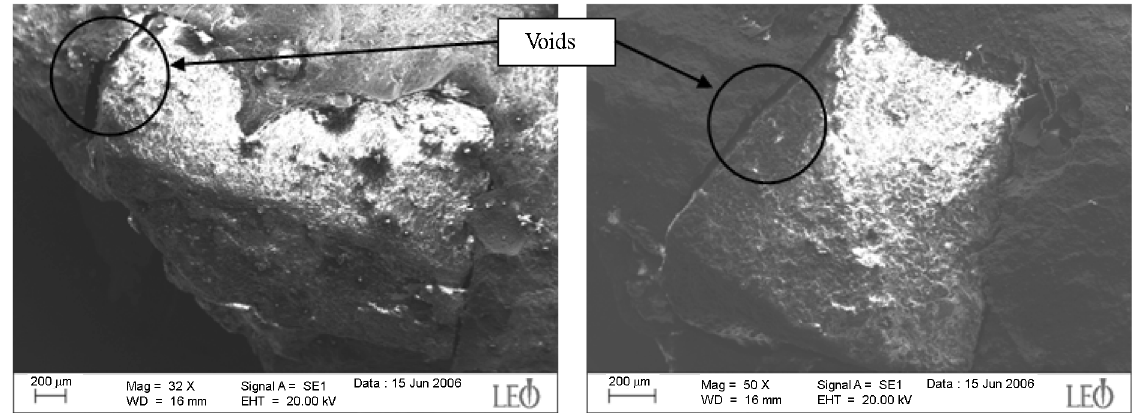
Fig. 3. SEM image of the concrete including APS